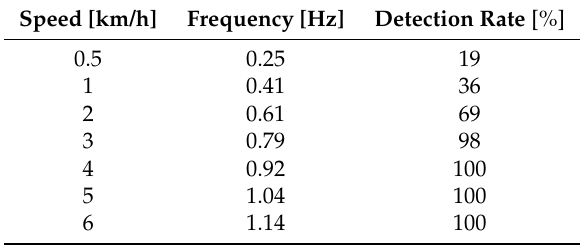
Table 1. Walking speeds, frequencies, and detection rate on the treadmill. Speed [km/h] Frequency